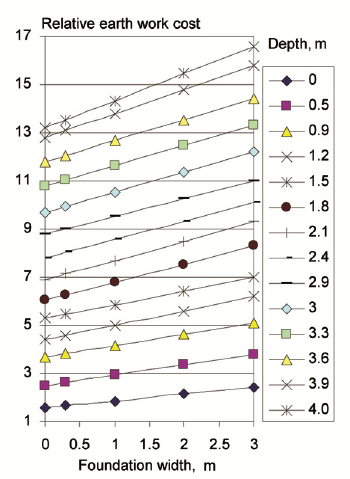
Fig. 1. Foundation types